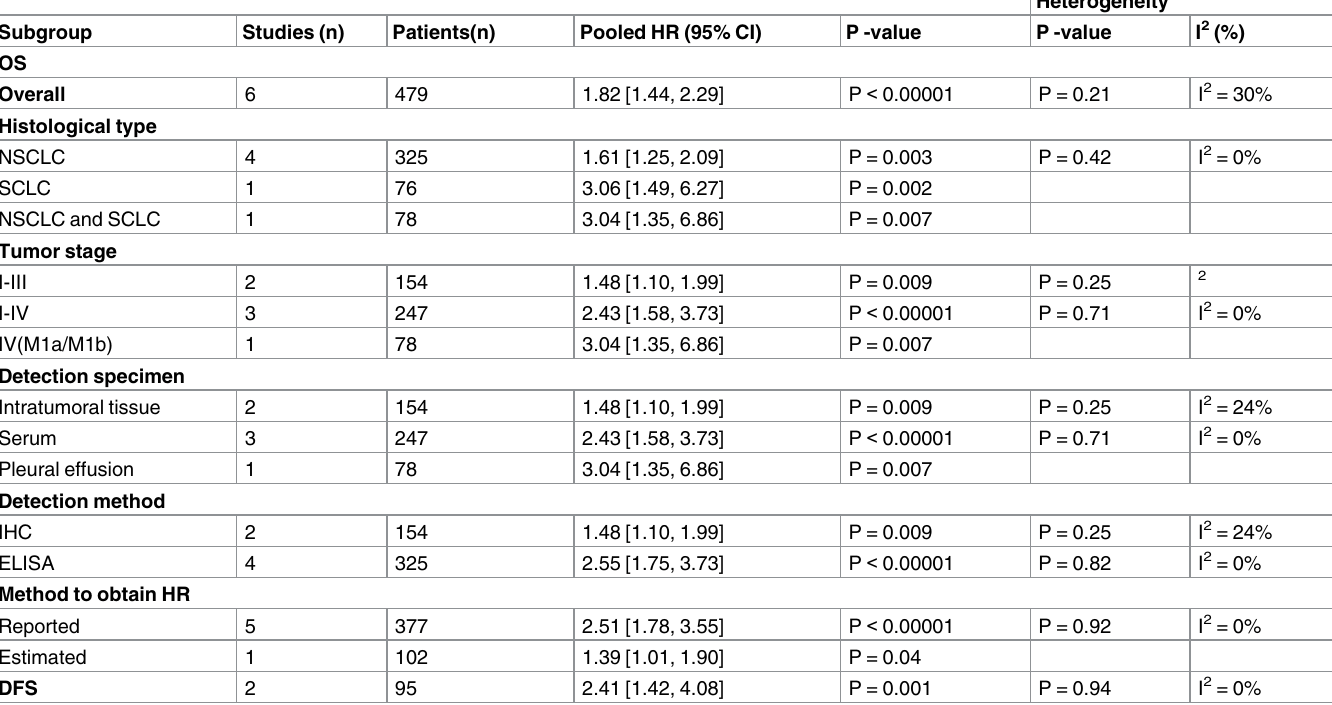
Table 3. A summary of hazard ratio (HR) for the overall and subgroup analyses of IL-17 expression and overall survival (OS) of lung cancer